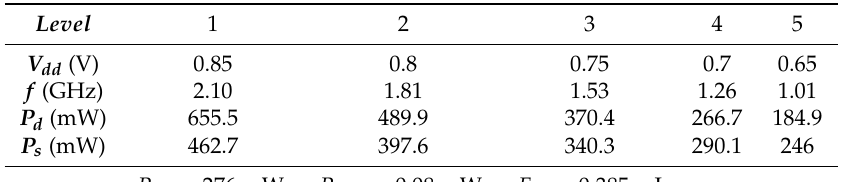
Table 4. Core power model parameters.